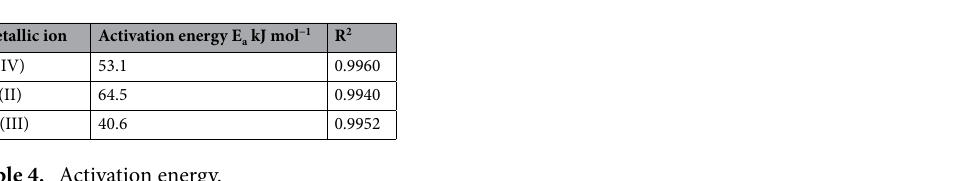
Table 4. Activation